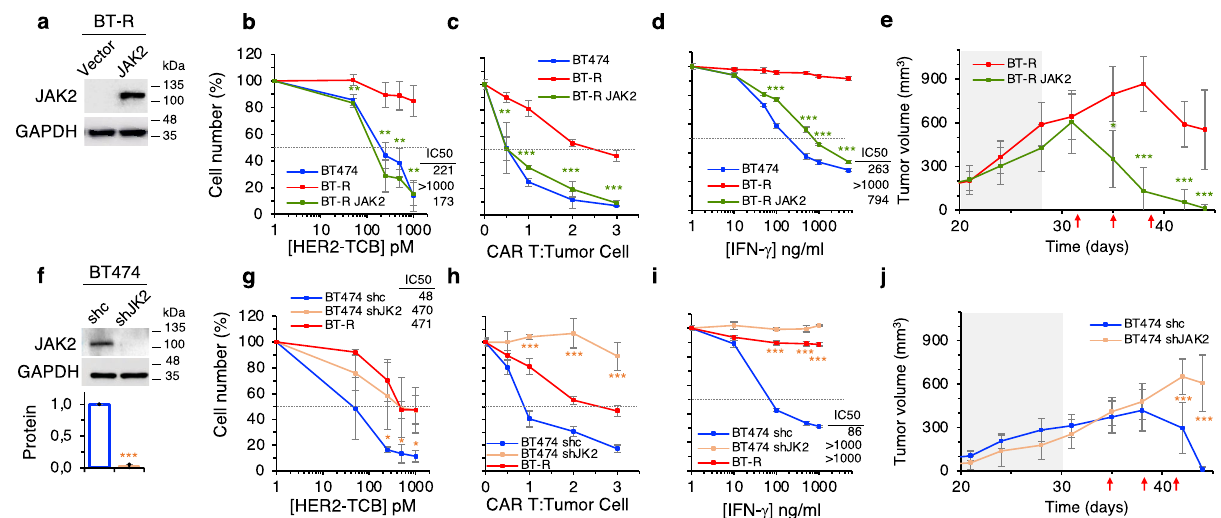
Fig. 5 The downmodulation of JAK2 causes resistance to redirected lymphocytes. a Levels of JAK2 in BT-R cells or the same cells stably transfected with a vector encoding JAK2 were determined by Western blot. Blot shown is representative of four independent experiments. b Cocultures of PBMCs with the indicated cells were treated with different concentrations of HER2-TCB for 72 h. Then, viable target cells were quanti fi ed by fl ow cytometry using EpCAM as a marker. c The indicated cells were treated with different ratios of CAR T cells. Cell numbers were calculated and expressed as in ( b ). d The indicated cells were treated with different concentrations of IFN- γ for 5 days. Cell numbers were estimated with the crystal violet staining assay. e Totally, 6.5 × 10 6 BT-R cells or the same cells expressing JAK2 were injected orthotopically into NSG mice. When tumors reached ~200 mm 3 (dark background), 10 7 PBMCs were injected i.p. Then animals were treated i.v. with 0.125 mg/kg HER2-TCB as indicated (red arrows). Tumor volumes are represented as averages± SD ( n = 7 per arm). f Levels of JAK2 in BT474 cells stably expressing a non-targeting shRNA (shc) or an shRNA targeting JAK2 (shJK2) were determined by Western blot. Results were normalized to BT474 shc. g – i The indicated cells were analyzed as in ( b – d ), respectively. j Totally, 6.5 × 10 6 BT474 cells stably expressing a non-targeting shRNA (shc) or an shRNA targeting JAK2 (shJAK2) were injected into NSG mice and treated as in ( e ). Tumor volumes are represented as averages± SD (shc, n = 10; shJAK2, n = 5). b ** p = 0.005, ** p = 0.003, ** p = 0.002, ** p = 0.002. c ** p = 0.002, *** p < 0.001. d *** p < 0.001. g * p = 0.05, * p = 0.05, * p = 0.02. h , i *** p < 0.001, two-tailed t test. e , j * p < 0.05, *** p < 0.001, two-way ANOVA and Bonferroni correction. Data are presented as mean ± SD of three ( b – d , h , i ) or four ( f , g ) independent experiments. Source data are provided as a Source Data fi